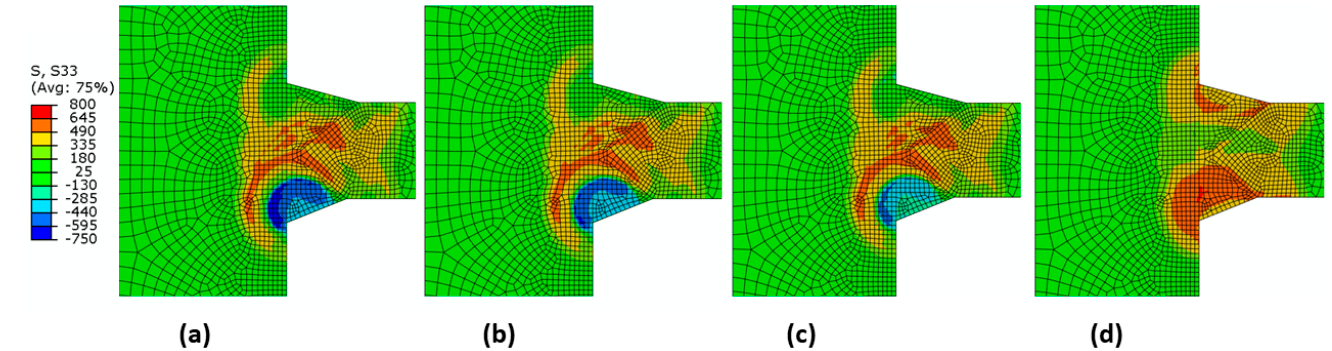
Figure 10 . Longitudinal residual stress in the FE model under different conditions (MPa), (a) Ms = 300 °C, (b) Ms = 350 °C, (c) Ms = 400 °C, and (d) no phase transformation.